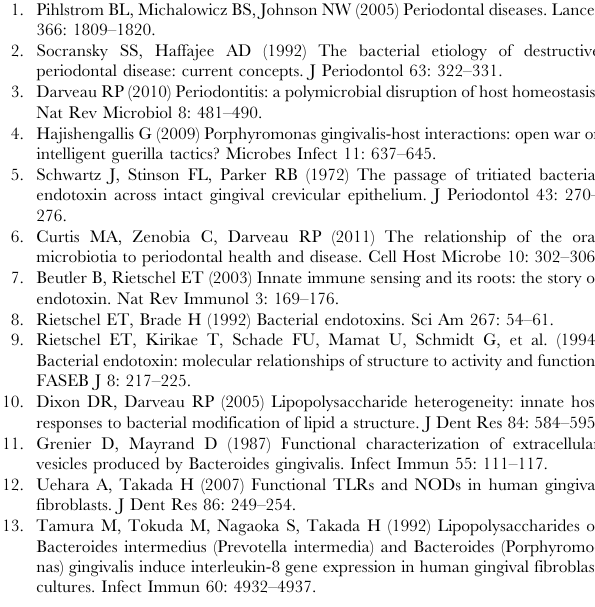
Table S2 Genes included in the TLR signaling pathway RT- PCR array kit (SA Biosciences). A total of 84 genes related to TLR signaling family were analyzed, including adaptor and effector proteins, members of the NF- k B, JNK/p38, IRF and JAK/STAT signaling pathways as well as downstream pathway genes. Table S3 Nucleotide sequence of primers for real-time PCR. and pro-inflammatory cytokines using purified RNA from HGFs stimulated with P. gingivalis LPS and E. coli